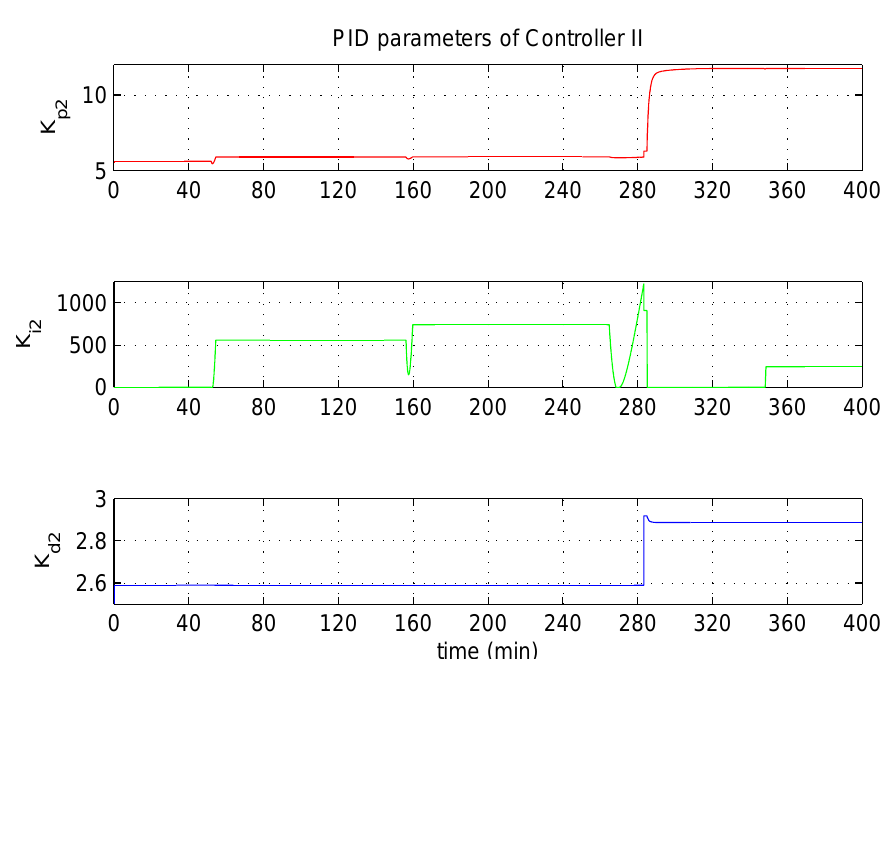
Figure 10. Variation of the PID parameters for Controller II during the tuning